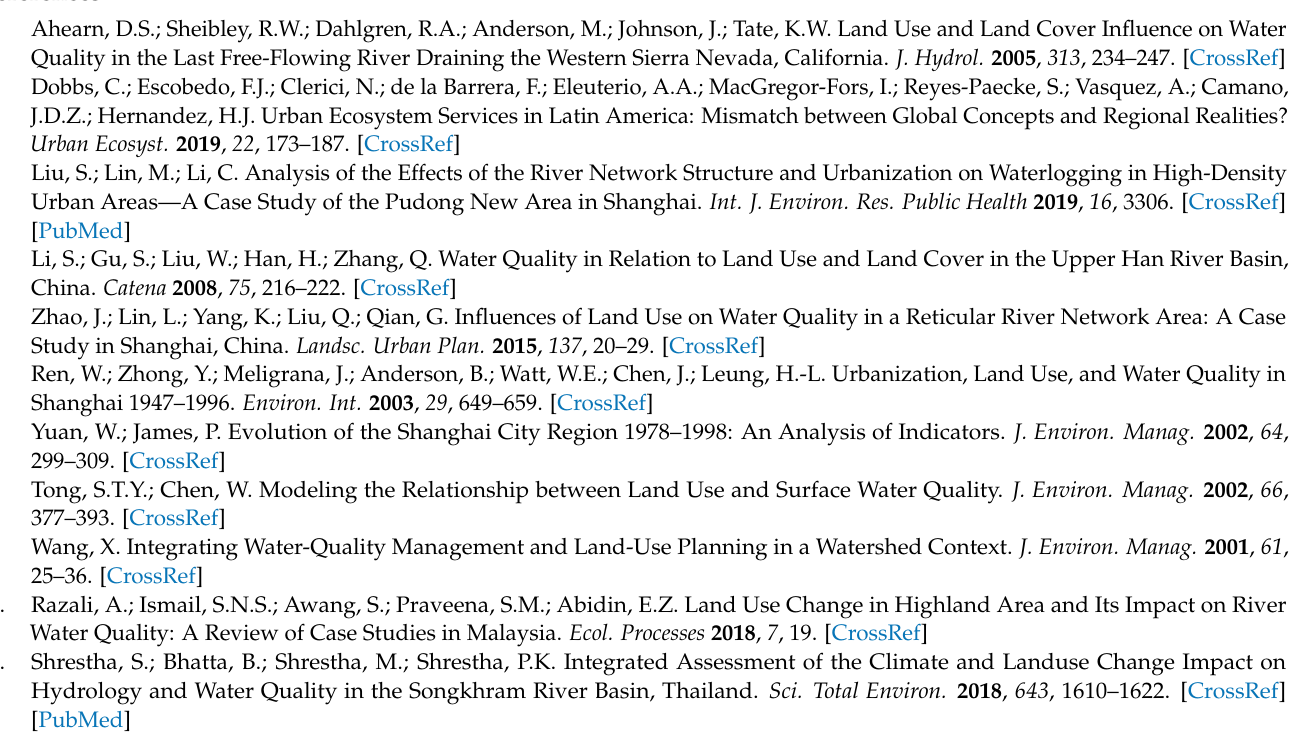
Table S2. Correspondence of the qualitative results of water quality indicators according to the numerical result of index